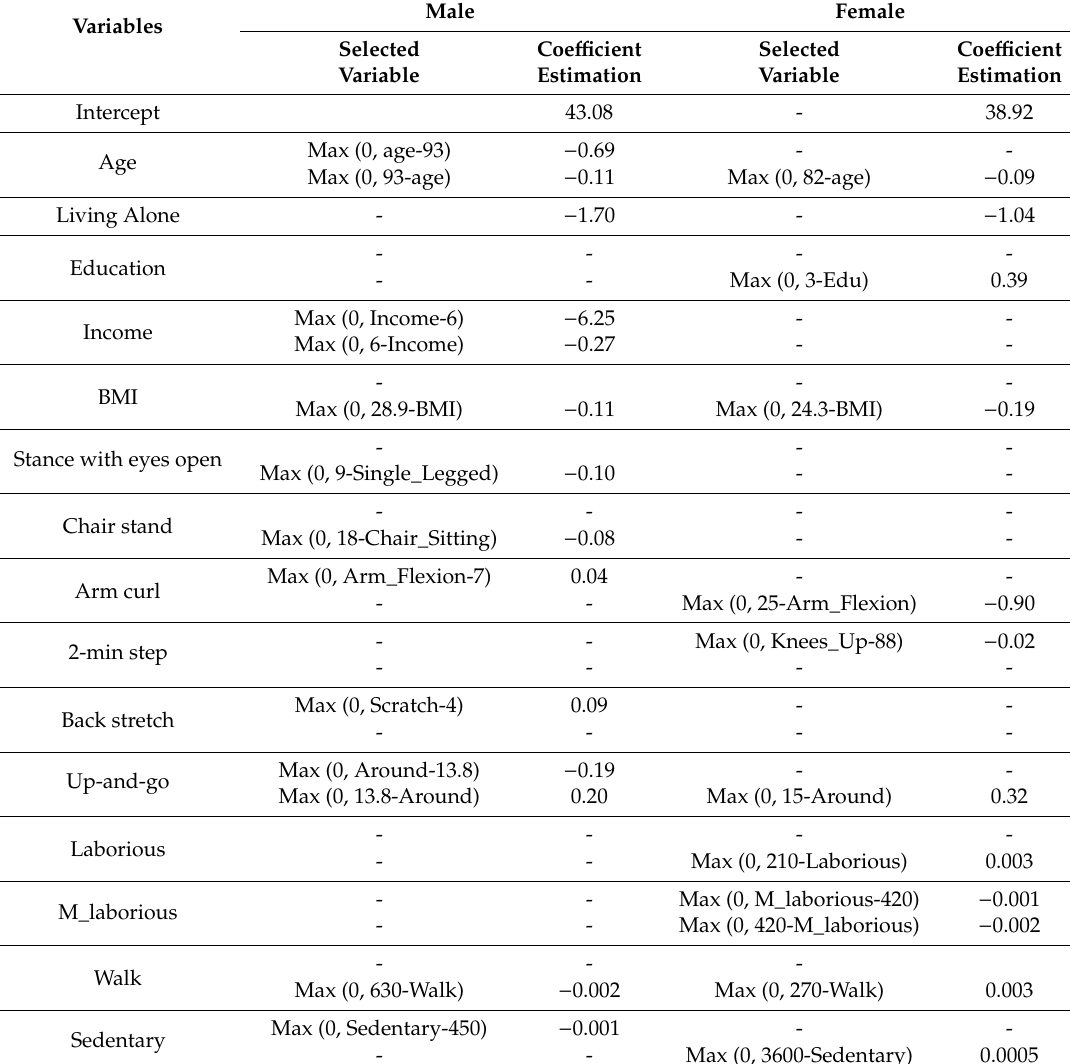
Table 2. Analysis results for happiness based on the MARS